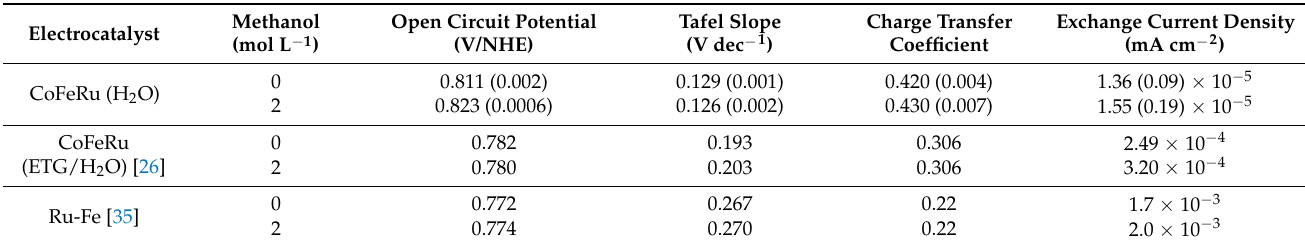
Table 2. Electrokinetic parameters and open circuit potentials of CoFeRu electrocatalyst synthesized using deionized water, and CoFeRu and Ru-Fe electrocatalysts reported in the